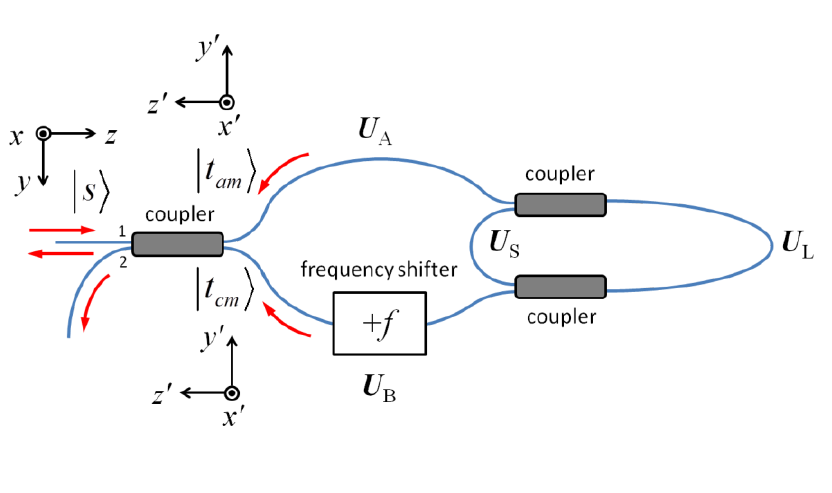
Figure 15. Input and output polarization of an FSI-CRD system. The coordinate system for the input polarization state s is x - y - z , and the coordinate system for the output states after m round trips t and t is x  - y  - z  cm am